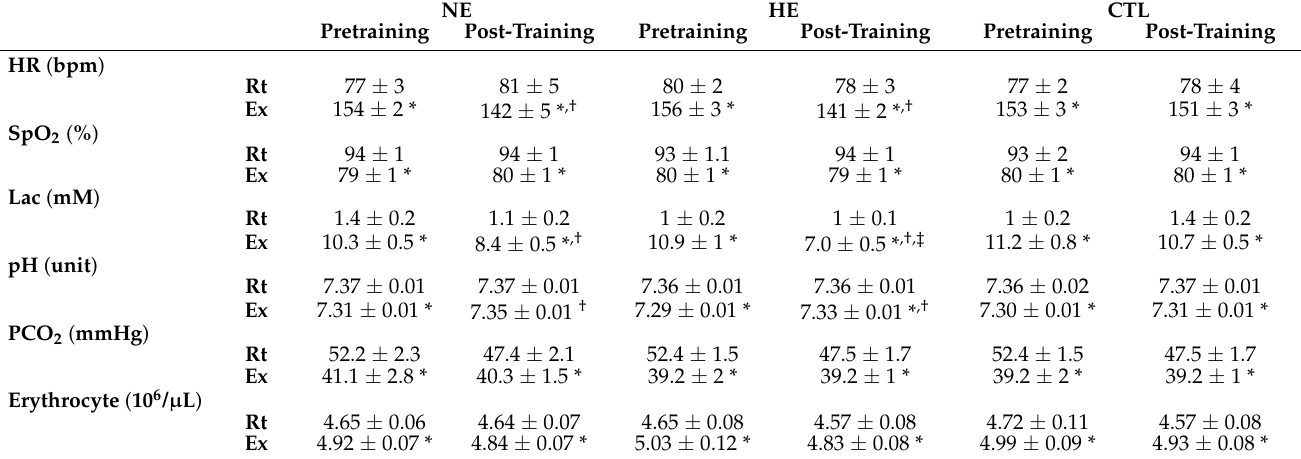
Table 2. Effects of NE and HE on erythrocyte characteristics and serum erythropoietin concentration in HET